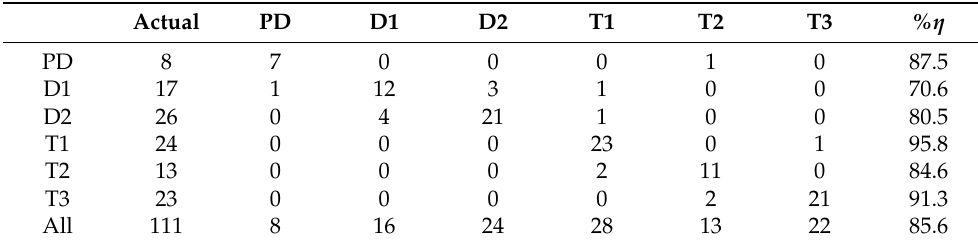
Table 10. Results of the proposed model using 111 testing